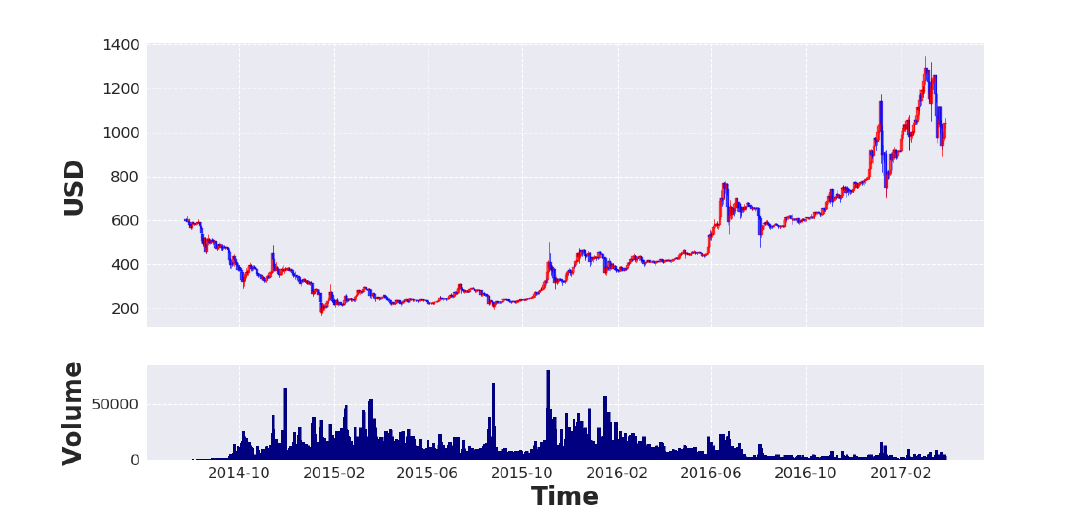
Figure 4. OHLC plot (Bitcoin price in USD). The dataset begins at the latter half of 2014. The price peaks at the beginning of 2017 in the same way as CNY, cf. Figure 3. Transaction volume was relatively constant before June 2016, whereas the volume of BTCCNY transactions in Figure 3 increased dramatically after the beginning of